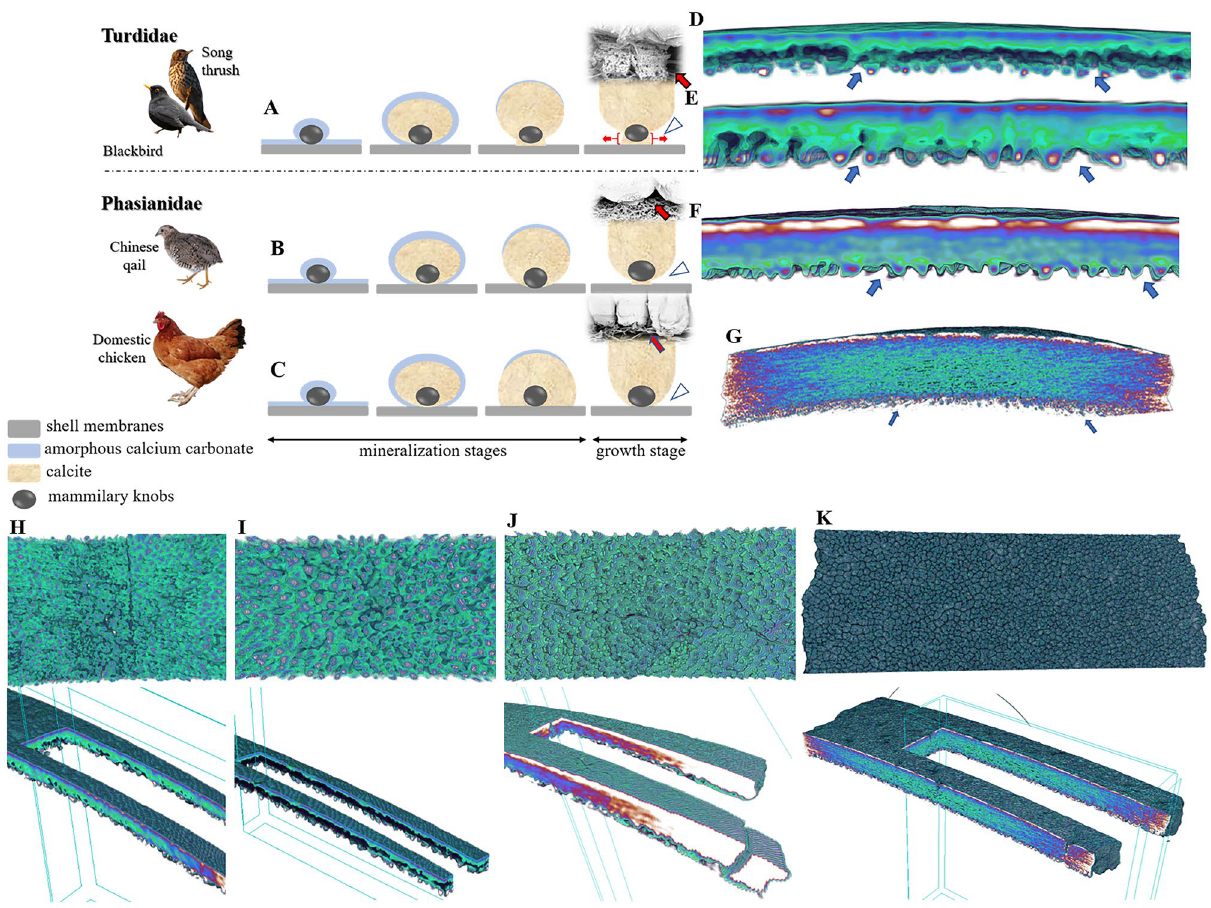
Figure 3. Comparison of the eggshell structure of blackbird ( Turdus merula ), song thrush ( Turdus philomelos ), Chinese (king) quail ( Synoicus chinensis ), and domestic chicken ( Gallus gallus ). Schematic representation illustrating the process of mineralization around mammillary knobs of Turdidae: blackbird and song thrush ( A ), and representatives phasianidae bird family: Chinese quail ( B ) and domestic chicken ( C ). The schema was made based on Le Roy et al. 11 The 3D scans reveal the cross section ( D – G ) and the inner surface of the eggshell ( H – K ). The lower scans ( H – K ) show the cross-section structure at two points of the eggshell simultaneously. ( D , H ): blackbird; ( E , I ): song thrush; ( F , J ): Chinese quail; ( G , K ): domestic chicken. All arrows indicate the spaces formed between